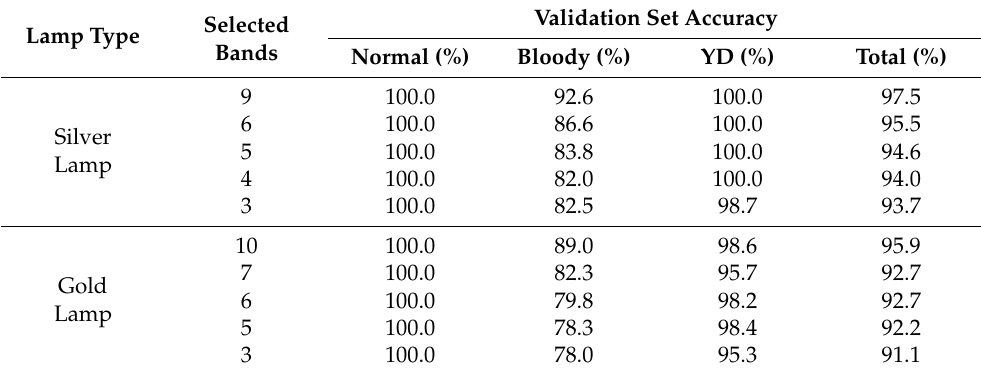
Table 4. Selected bands of the PLS-DA model results using silver and gold tungsten lamps for the discrimination of abnormal